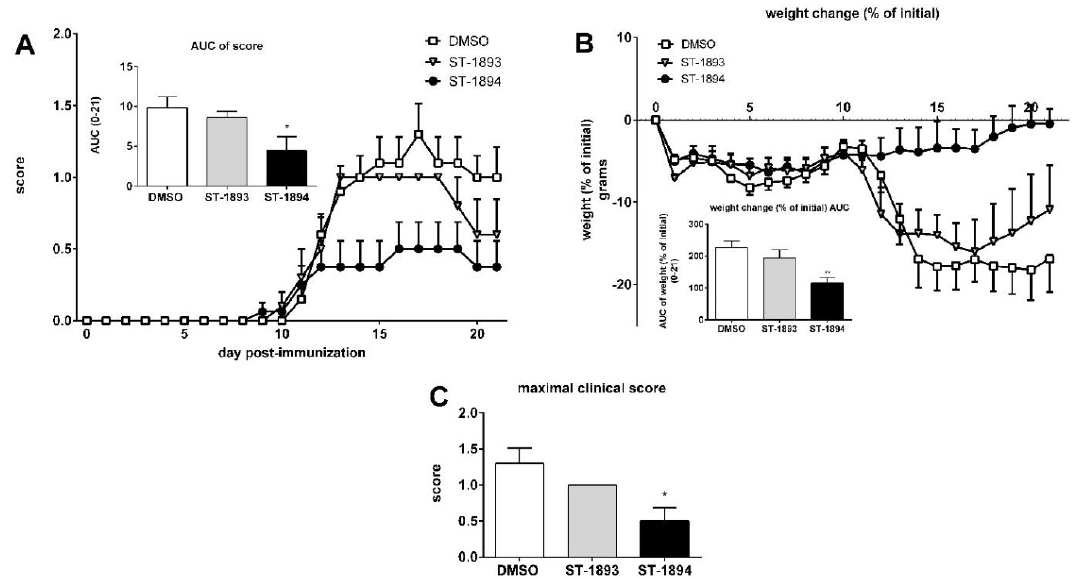
Figure 10. Effect of ST-1893 and ST-1894 on EAE disease course in SK-2 knockout mice. EAE was induced in C57BL/6J SK-2 knockout mice and, starting from day 5 until day 20 post immunization, they were injected with ST-1893, ST-1894, or DMSO dissolved in PBS at 5 mg/kg as explained in Section 4. Graph in ( A ) represents the daily clinical score based on a four-point scoring system, and the inset graph presents the area under the curve (AUC) value from the scores from day 0 until day 21. Graph in ( B ) shows the weight change based on the weight at day 0 set as 0%, with the respective AUC calculation in inset. The maximal clinical score reached for each individual mouse is presented in graph ( C ). Results are presented as means ± SEM ( n = 10, DMSO; n = 5, ST-1893; n = 8, ST-1894); * p < 0.05, ** p < 0.01, statistically significant when compared to the DMSO control EAE group.